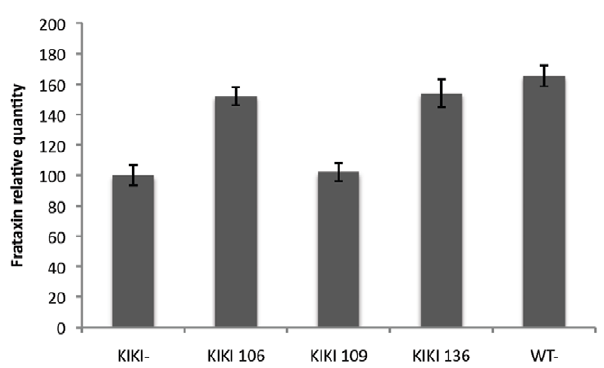
Figure 5. Effect of compounds 106, 109 and 136 in unstimu- lated KIKI splenocytes. Splenocytes were collected from pooled KIKI spleens (n=3) or WT spleens. Spleen mononuclear cells were cultured in triplicate for 48 hours with one of HDACi 106 , 109 and 136 at 10 m M or with DMSO for KIKI samples. WT samples were cultured in triplicate for 48 hours with. Quantitative real-time RT-PCR was used to determine relative Fxn levels for each condition using RER1 and b 2M as control housekeeping genes. DMSO KIKI condition was set to value 1. Error is represented as the standard deviation of the mean from 3 determinations. p , 0.001 for 106 and 136 KIKI